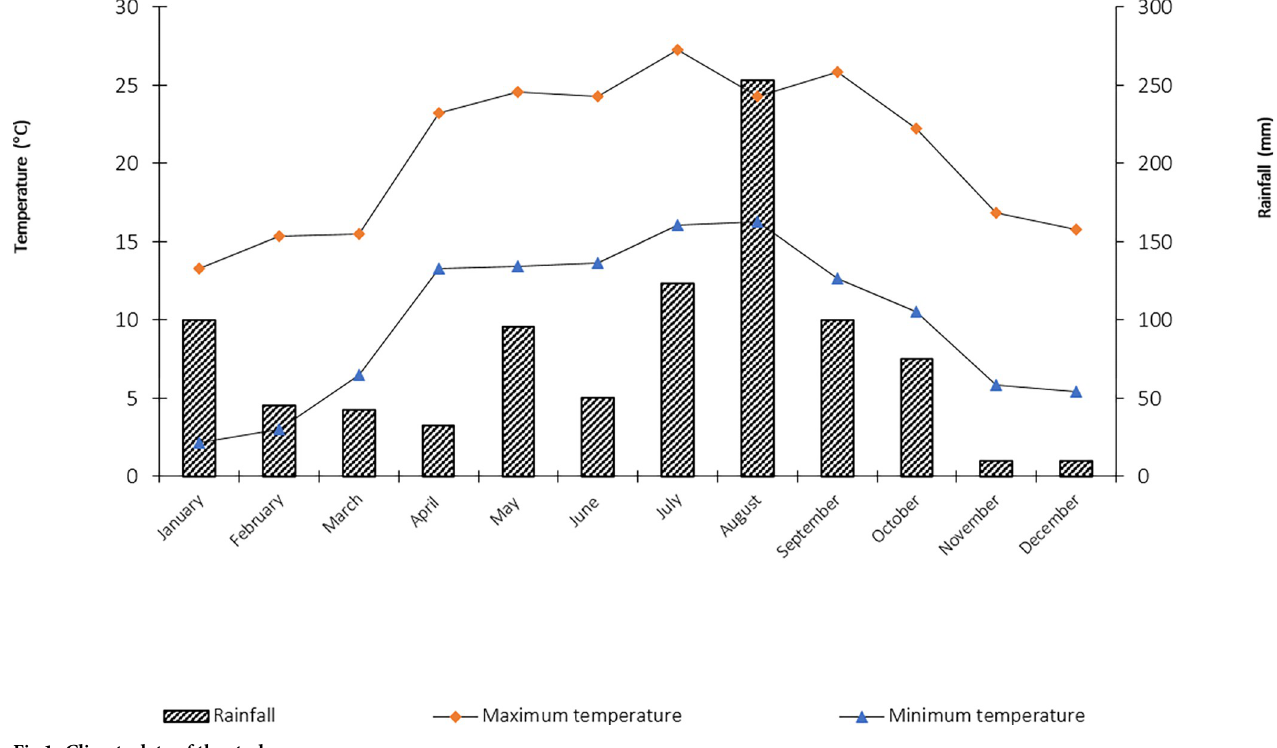
Fig 1. Climate data of the study